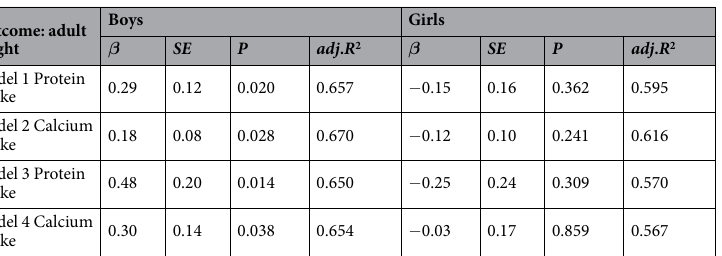
Outcome: adult height